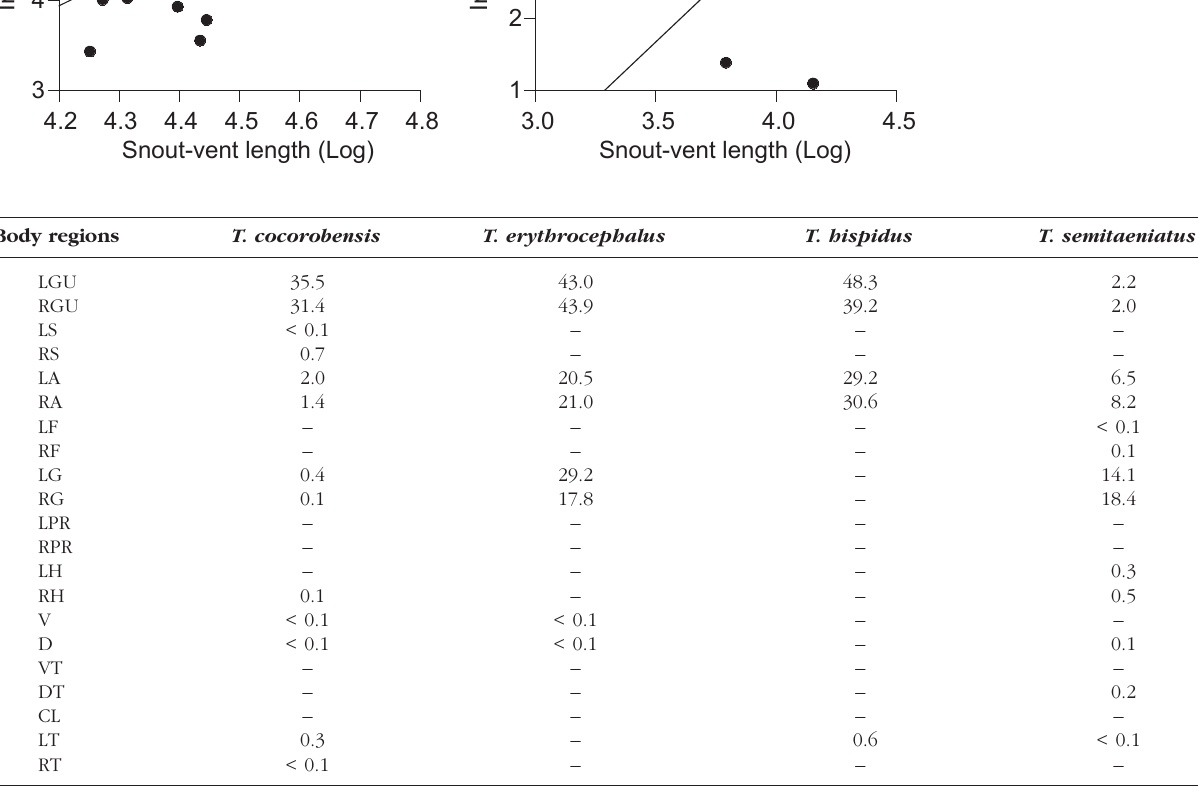
Fig. 2. – Relationship bet- ween snout-vent length (log) and intensity of infestation (log) by trombiculid mite Eutrombicula cf. alfreddu- gesi on (a) Tropidurus ery- throcephalus (R 2 = 0.30; F = 4.68; P = 0.05; N = 13); (b) Tropidurus cocorobensis (R 2 = 0.55; F = 17.48; P < 0.005; N = 16); (c) Tropi- durus hispidu (R 2 = 0.41; F = 12.41; P < 0.005; N = 20); and (d) Tropidurus semitae- niatus (R 2 = 0.26; F = 10.64; P < 0.01; N = 33).